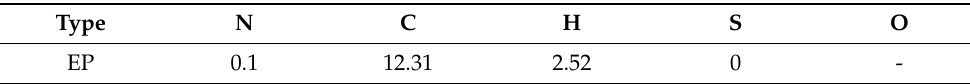
Table 2. Organic element composition of EP (%).